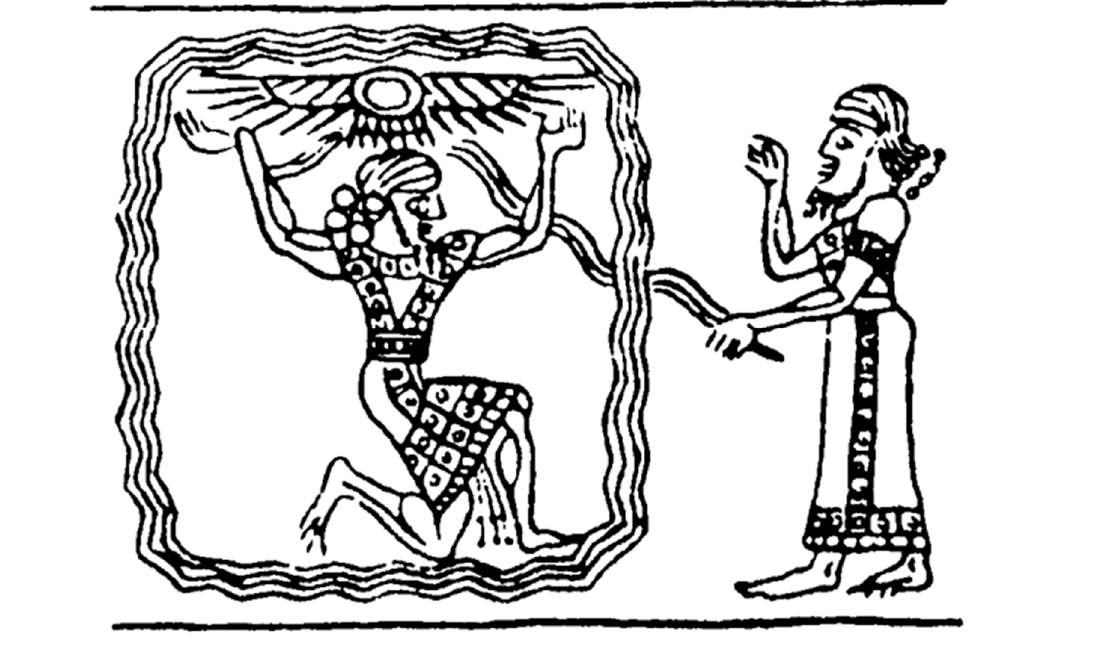
Figure 13. Middle Assyrian seal depicting a kneeling figure supporting a winged sun that separates the waters above from the waters below (Matthews 1990, no.